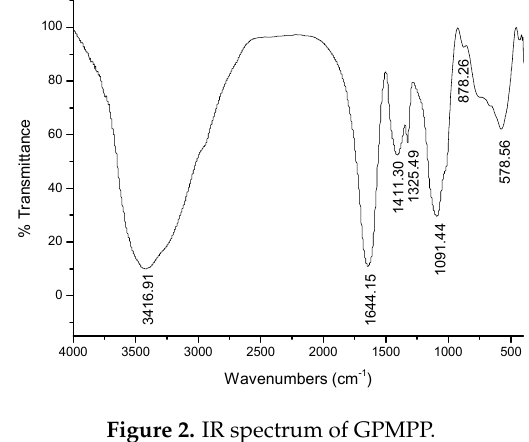
Figure 2. IR spectrum of GPMPP.